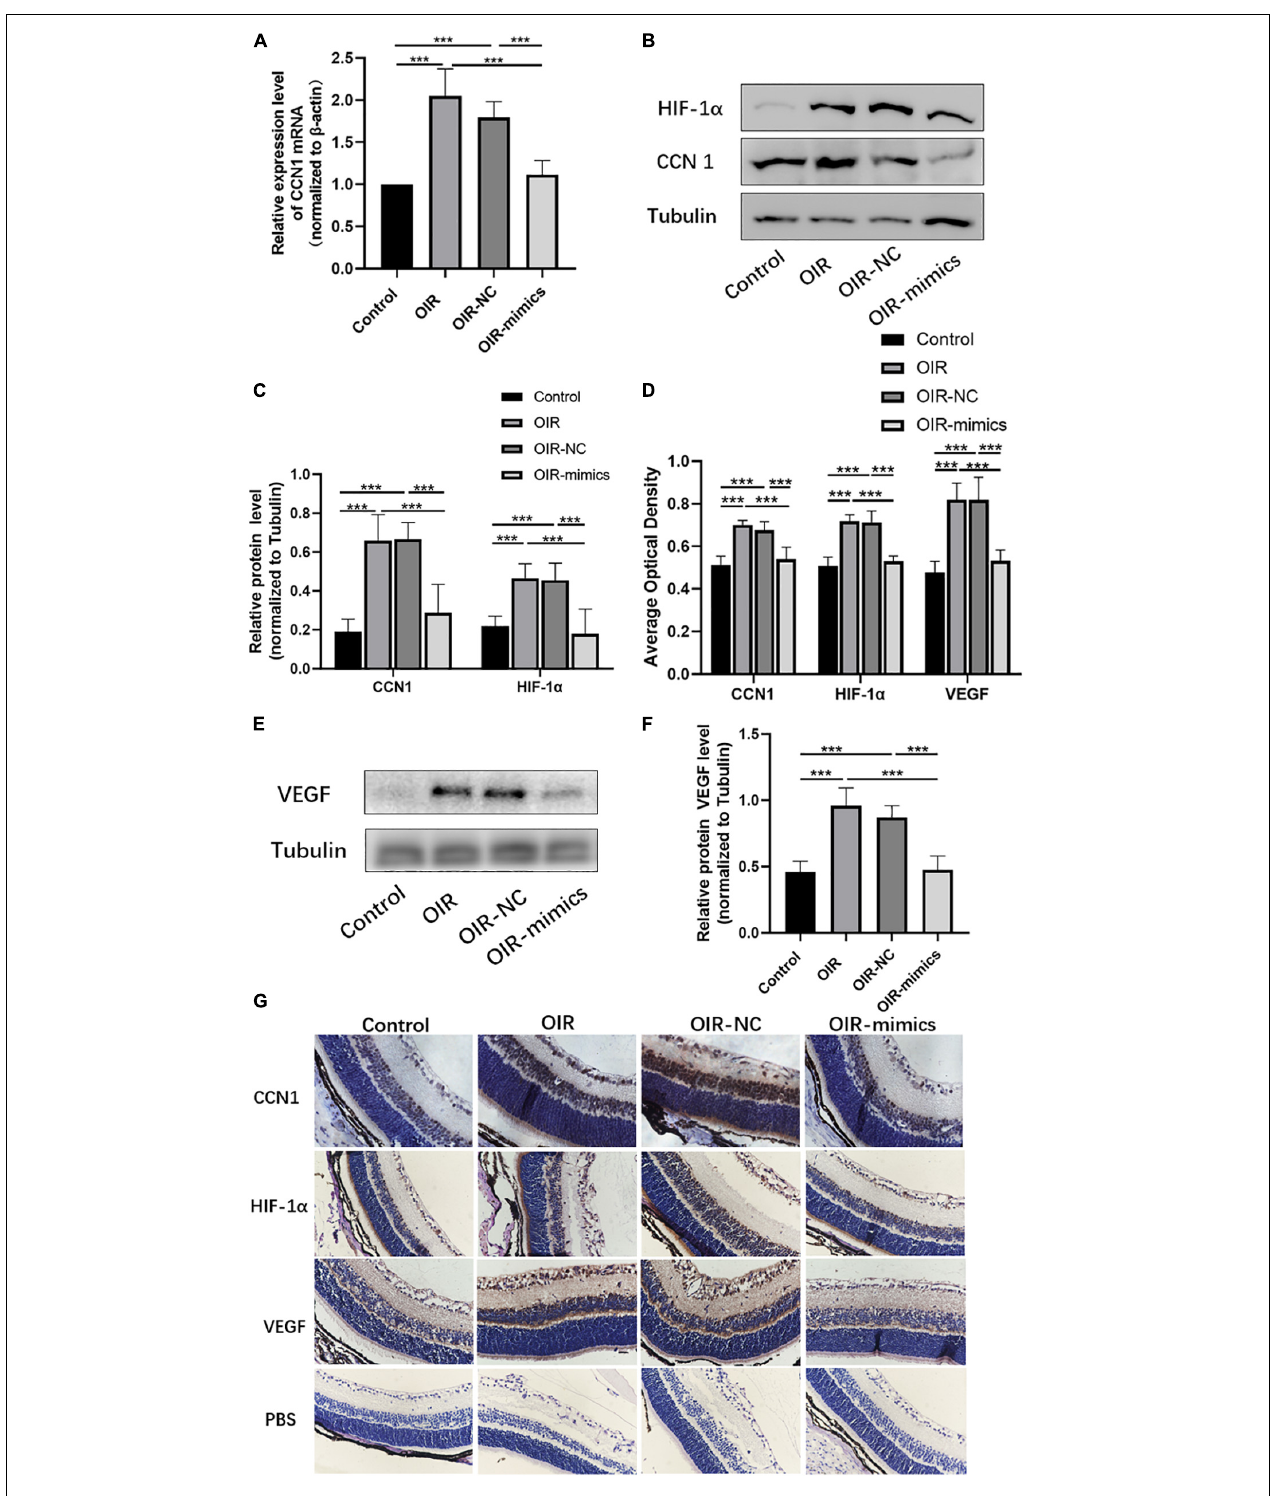
FIGURE 8 | Overexpression of miR-145-5p inhibits the expression of CCN1, HIF- α , and VEGF expression. (A) CCN1 mRNA expression level (mean ± SD, n = 6), *** P < 0.001. (B) Western blot results of CCN1 and HIF- α . (C) Quantitative analysis of band intensities from Western blots shown in (B) (mean ± SD, n = 6). *** P < 0.001. (D) The average optical density of the immunohistochemical map in different treatment groups (mean ± SD, n = 7). *** P < 0.001. (E) Western blot results of VEGF. (F) Quantitative analysis of band intensities from Western blots shown in (E) (mean ± SD, n = 6). *** P < 0.001. (G) Immunohistochemical map of CCN1, HIF- α , and VEGF in the retinal